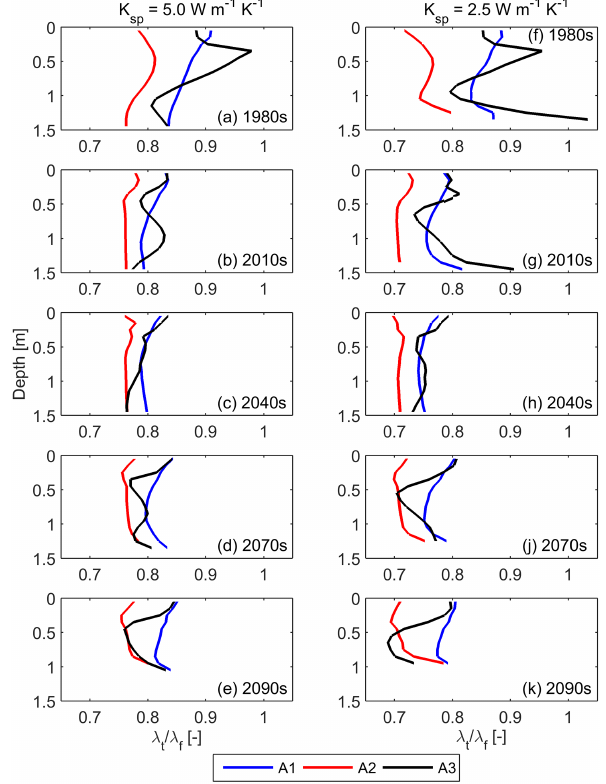
Figure 13. Comparison of the influence of soil architecture and thermal conductivity of soil particles ( λ sp ) on the seasonal thermal conductivity ratio λ t /λ f in the shallow soils over the period from 1980 to 2100. (a–e) Decadal mean λ t /λ f of A1, A2 and A3 with a high λ sp = 5.0Wm − 1 K − 1 at selected decades; (f–j) the same as (a–e) but with a low λ sp = 2.5Wm − 1 K − 1 . seasonal λ t /λ f of the shallow soils (0–1.5 m) over the sim- ulating period of 1980–2100. Decadal mean λ t /λ f were cal- culated for all the simulations. Compared to the same soil architectures but different thermal conductivities of soil par- ticles, the maximum decadal mean λ t /λ f in the left panel with λ sp = 5.0 W m − 1 K − 1 are higher than that in the right panel with λ sp = 2.5 W m − 1 K − 1 . However, the differences of λ t /λ f among the architectures in the right panel are bigger than in the left panel. Besides, the maximum values of λ t /λ f in A3 are bigger than the other two from the 1980s to 2040s, then they gradually become smaller. Generally, the shrinking differences in decadal mean λ t /λ f among the three architec- tures indicate that the effects of the stratified active layers on permafrost warming are significant in the early state of permafrost degradation and will decrease afterwards. These results are all consistent with the thermal regimes in Fig.